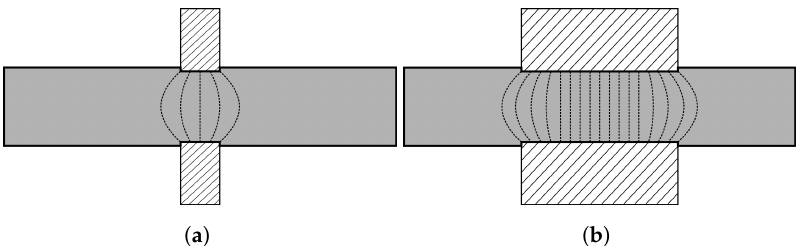
Figure 1. Simplified representation of force flow lines during cold rolling: ( a ) Small compressed length. ( b ) High compressed